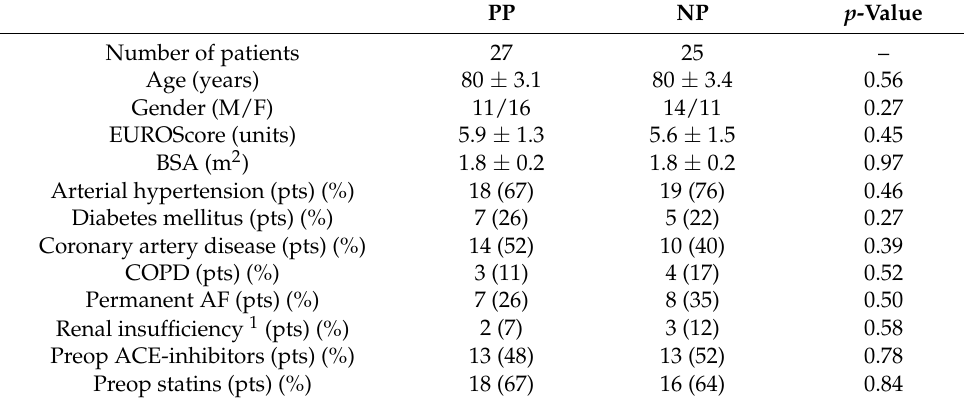
Table 1. Patients’ main demographic and clinical